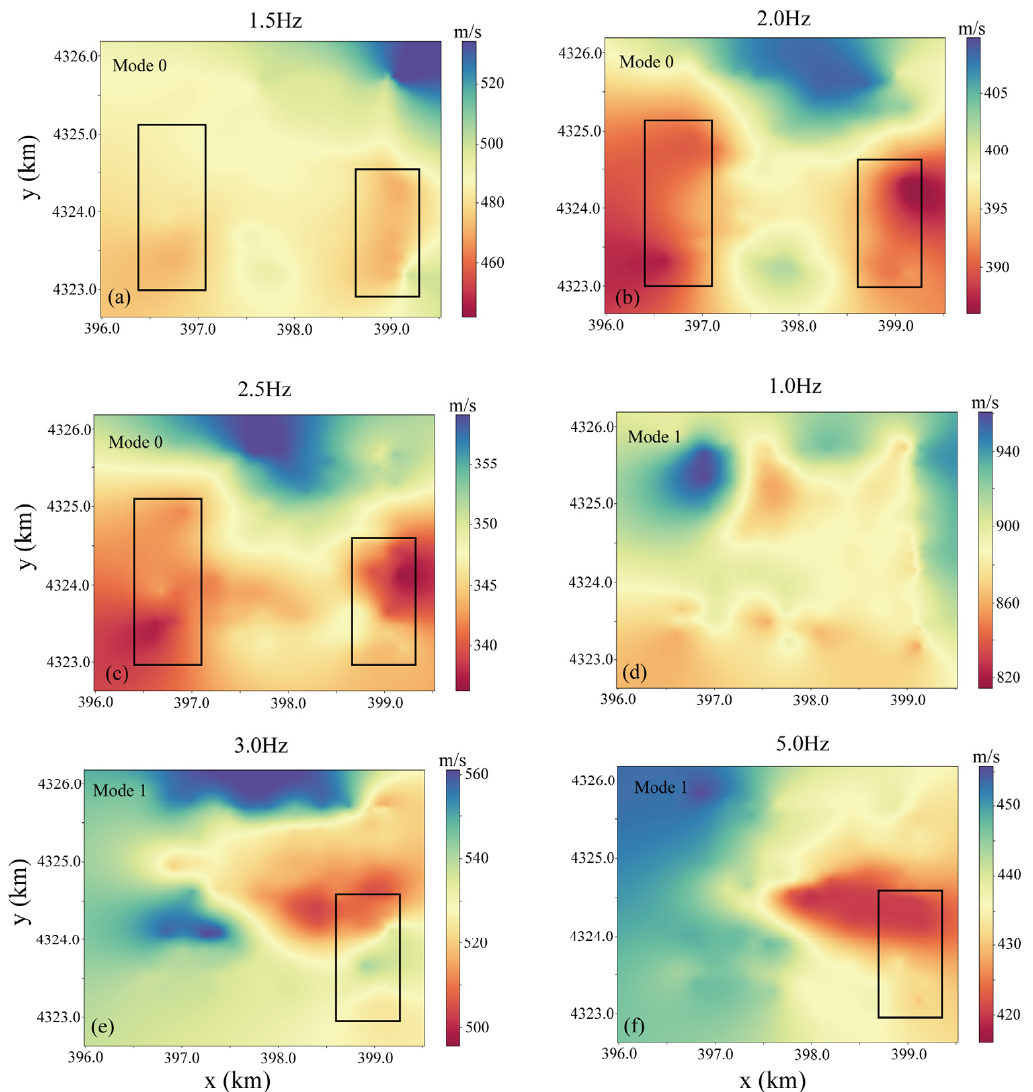
Figure 4. Phase velocity maps. ( a ), ( b ), and ( c ): Phase velocity map of the fundamental mode (mode 0) at the frequencies of 1.5, 2.0, and 2.5 Hz); ( d ), ( e ), and ( f ): Phase velocity map of the first higher mode (mode 1) at the frequencies of 1.0, 3.0, and 5.0 Hz. The rectangles in the figure show the anomalous areas mentioned in the